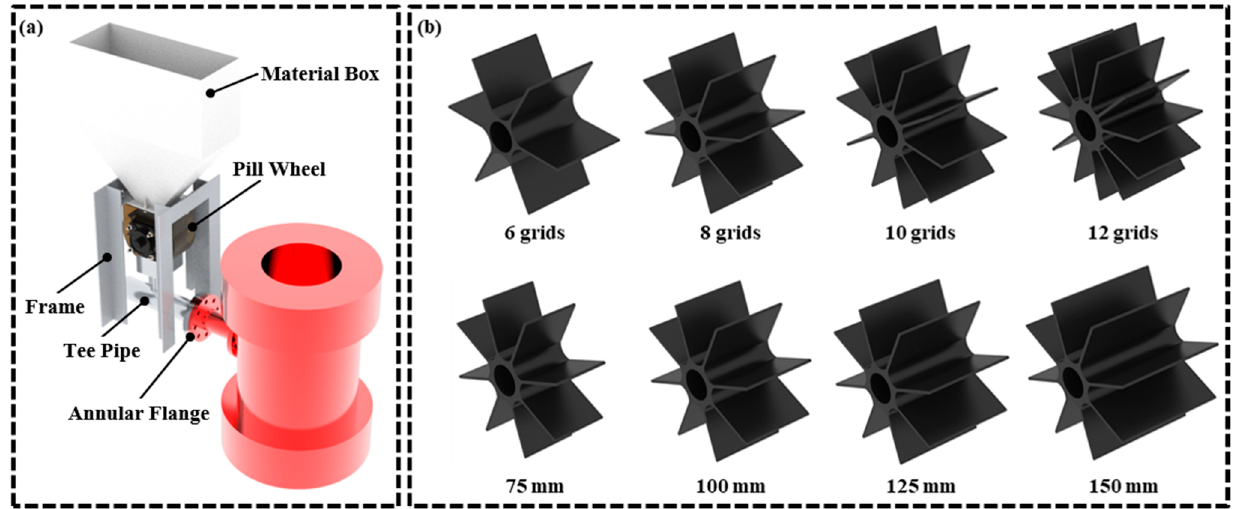
Figure 1. Entity diagram of the pill discharge device and different pill discharge wheels: ( a ) the pill discharge device; ( b ) different grid numbers and widths of pill discharge wheels.